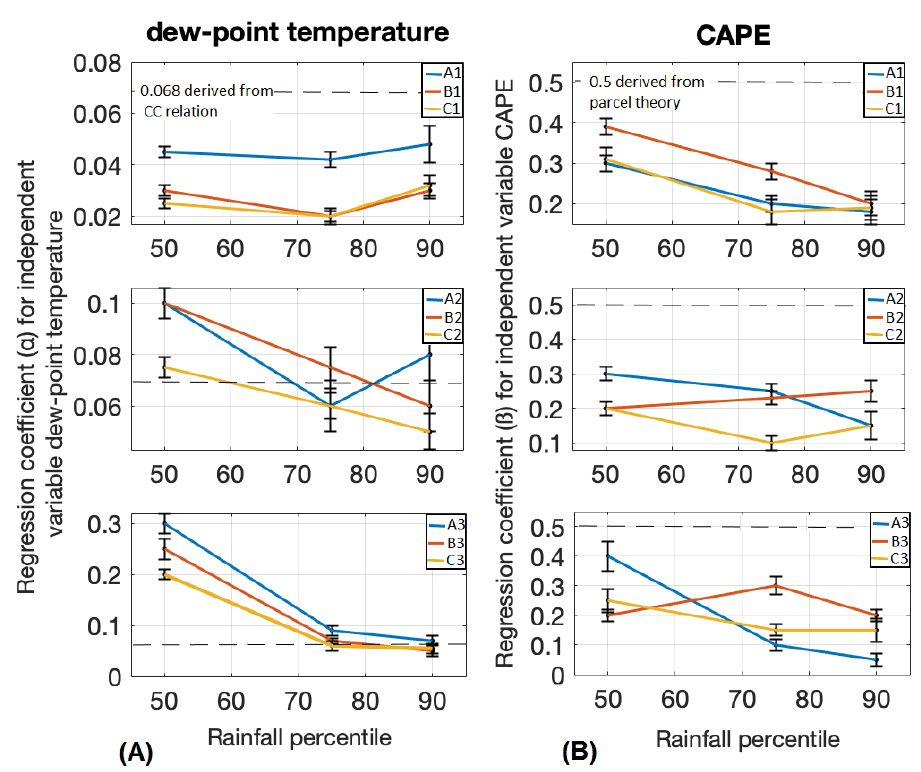
Figure 12. (( A ) dew-point temperature) Changes in the regression coefficient for the independent variable dew-point temperature for all boxes (Figure 4). Dashed line shows the coefficient based on CC relation with about 6.8% ◦ C − 1 increase of rainfall with temperature. ( B ) (CAPE) Changes in the regression coefficient for the independent variable CAPE for all boxes. Dashed line shows the coefficient based on parcel theory. Note that we have used a linear model fitting function to fit the regression model (Equation ( 4)) in our study